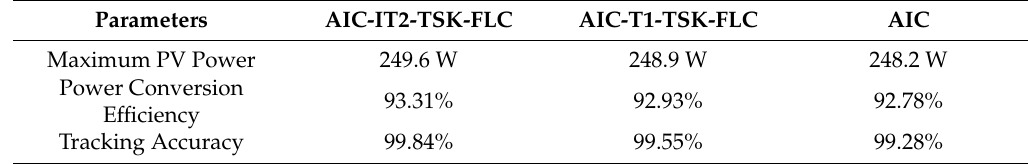
Table 4. Performance comparison of all maximum power point tracking (MPPT)